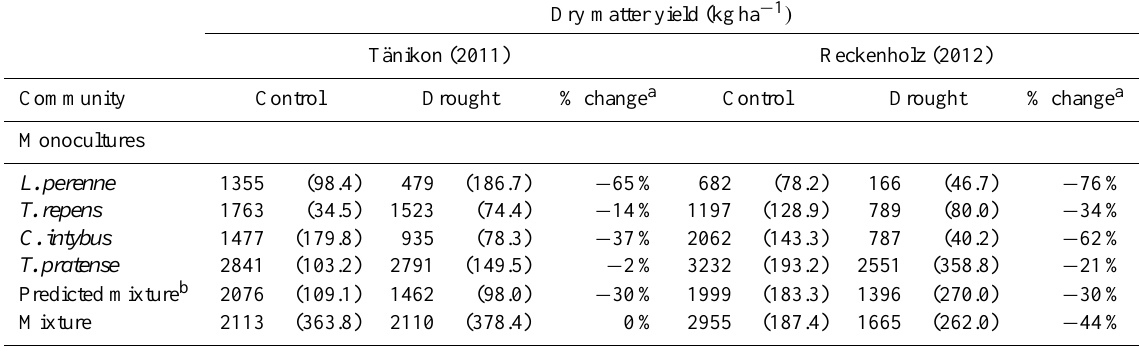
Table 2. Average aboveground dry matter yield (kg ha − 1 , SE in parentheses, n = 3) of the plant communities and the proportion of dry matter yield of the sown species in the mixture under control and drought conditions during the final cut of the drought period in Tänikon (2011) and Reckenholz (2012) (see Tables S2 and S3 in the Supplement for statistical significance of treatment